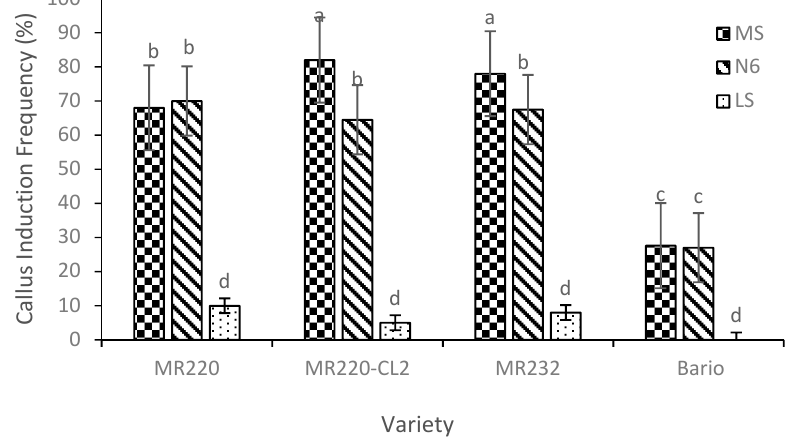
Figure 3. Callus induction frequency for four Malaysian rice varieties cultured on different basal media MS, N6, and LS media. Mean values marked with the same letters do not differ significantly ( p ≤ 0.05) in Tukey’s test. Vertical bars represent ± SD ( n = 3).